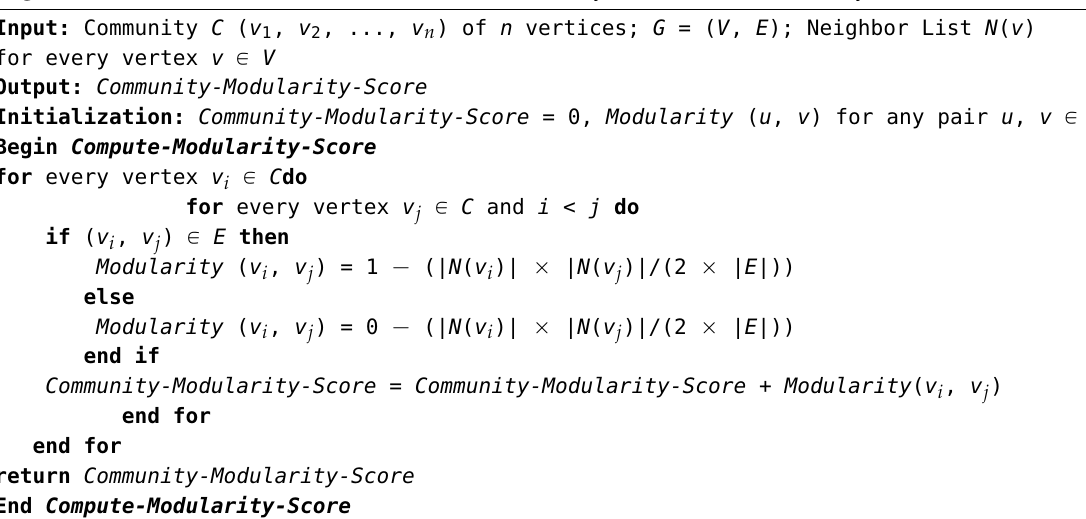
Algorithm 5 Pseudo Code to Determine the Modularity Score for a